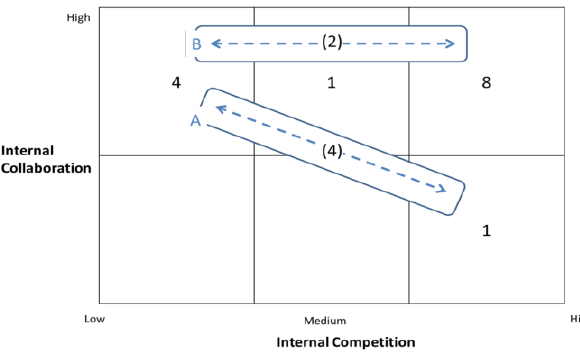
Figure 4: Distribution of preferred hybrid